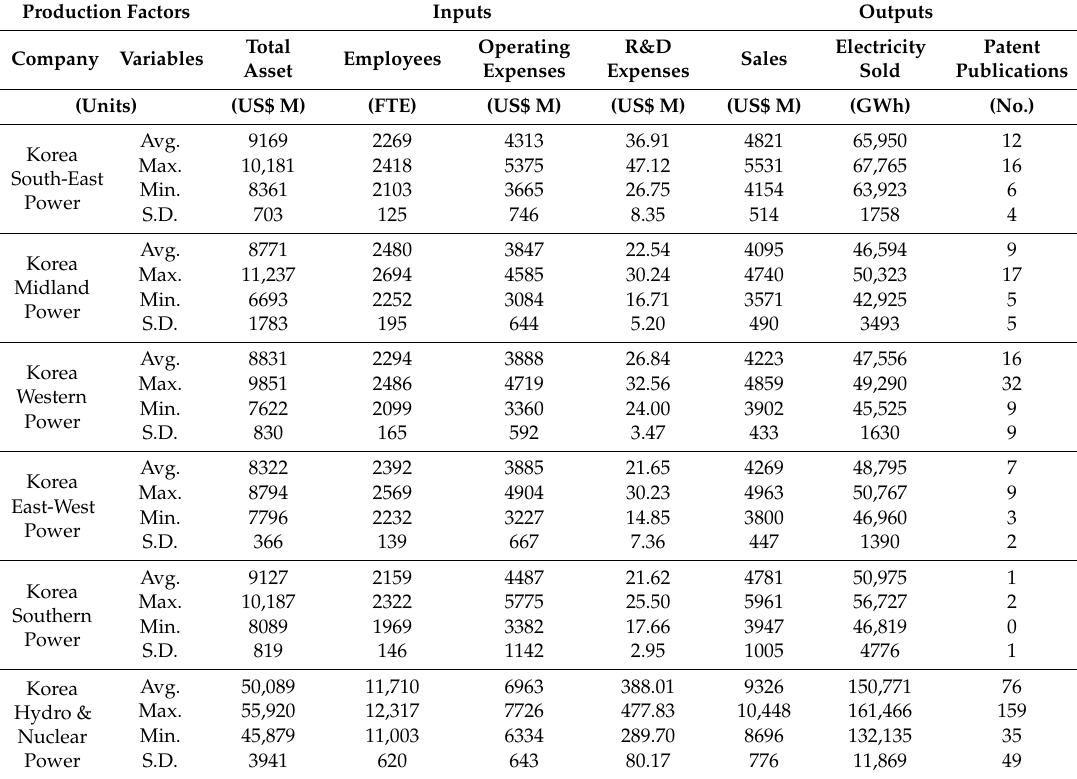
Table 5. Descriptive Statistics of Korean Power Companies (cid:48)